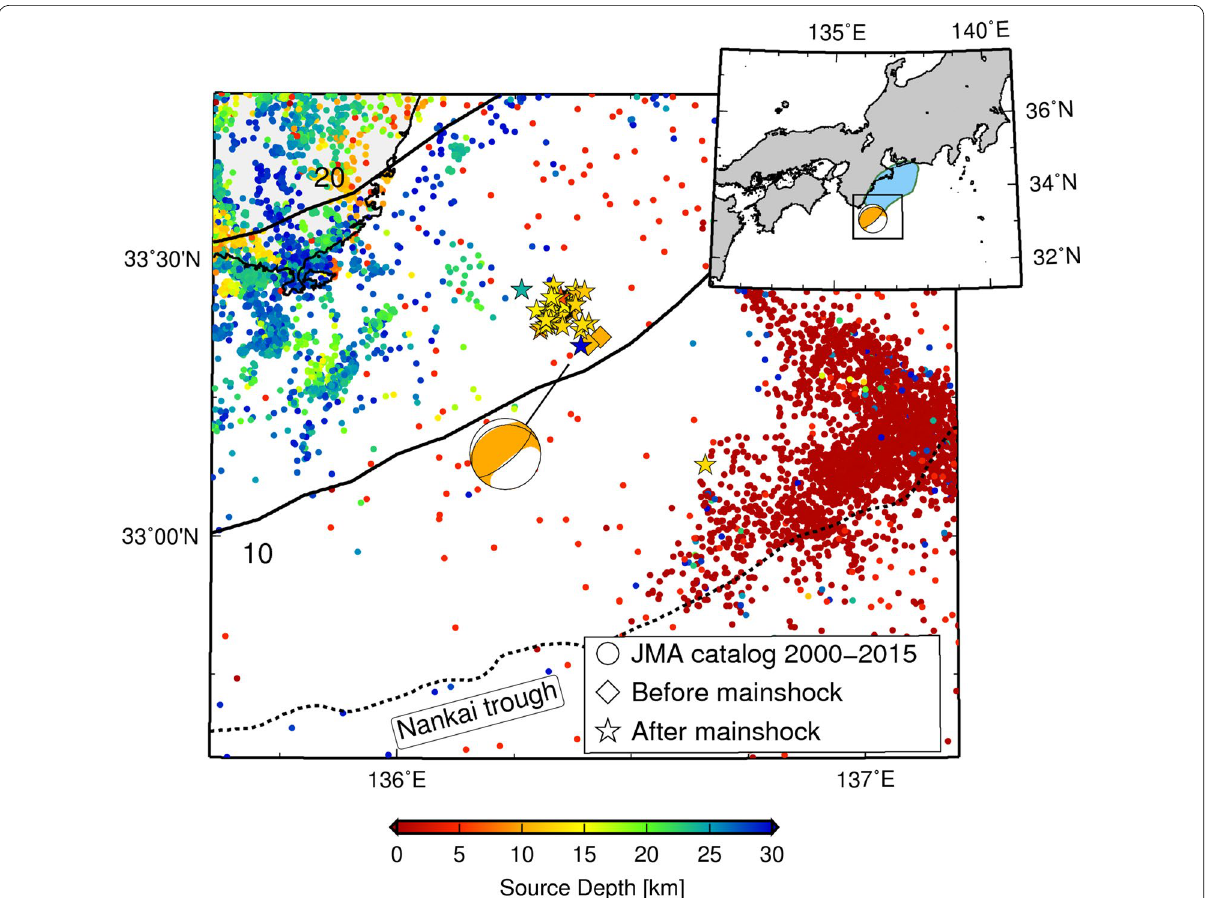
Fig. 11 Seismic activity in the SE offshore Mie region. Circles are referred from the JMA unified catalog. Diamonds and stars are earthquakes that occurred on 1–2 April around the epicenter region, and these were determined via traveltime analysis by Wallace et al. (2016). Diamonds and stars denote earthquakes before and after the 2016 SE offshore Mie earthquake, respectively. The color of each symbol represents the hypocenter depth of each event. The plotted focal sphere represents our MT result of the 2016 SE offshore Mie earthquake. Isodepth lines of the upper surface of the Philippine Sea plate are shown at 10-km intervals (Baba et al. 2002; Hirose et al. 2008). The blue shaded area in the upper-right subfigure represents the expected source region of the Tonankai